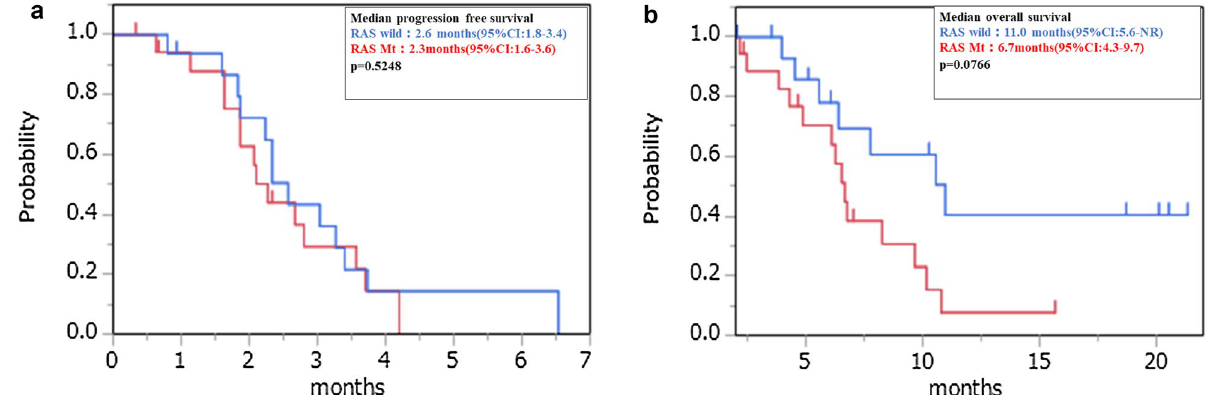
Figure 2. Kaplan–Meier plots of ( a ) progression-free survival (PFS) and ( b ) overall survival (OS) among study participants. Red line: RAS wild group, Blue line: RAS mutant group.